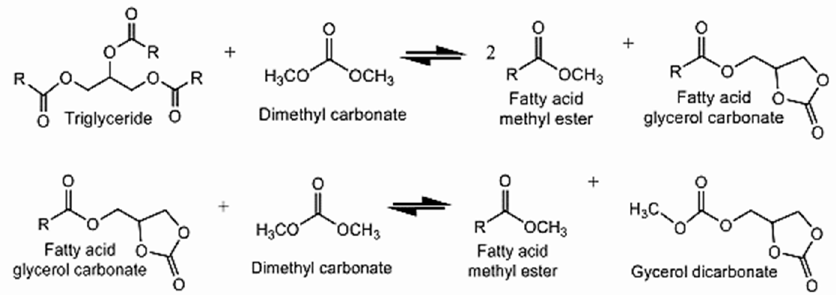
Figure 7. Reaction scheme for biodiesel production under supercritical dimethyl carbonate condition.